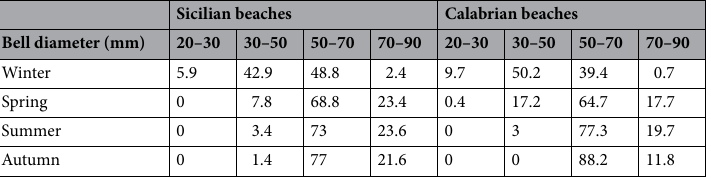
Table 1. Bell diameter of the stranded specimens of Pelagia noctiluca collected along the Sicilian and Calabrian coasts: seasonal trend of the relative incidence (in %) of each size class.